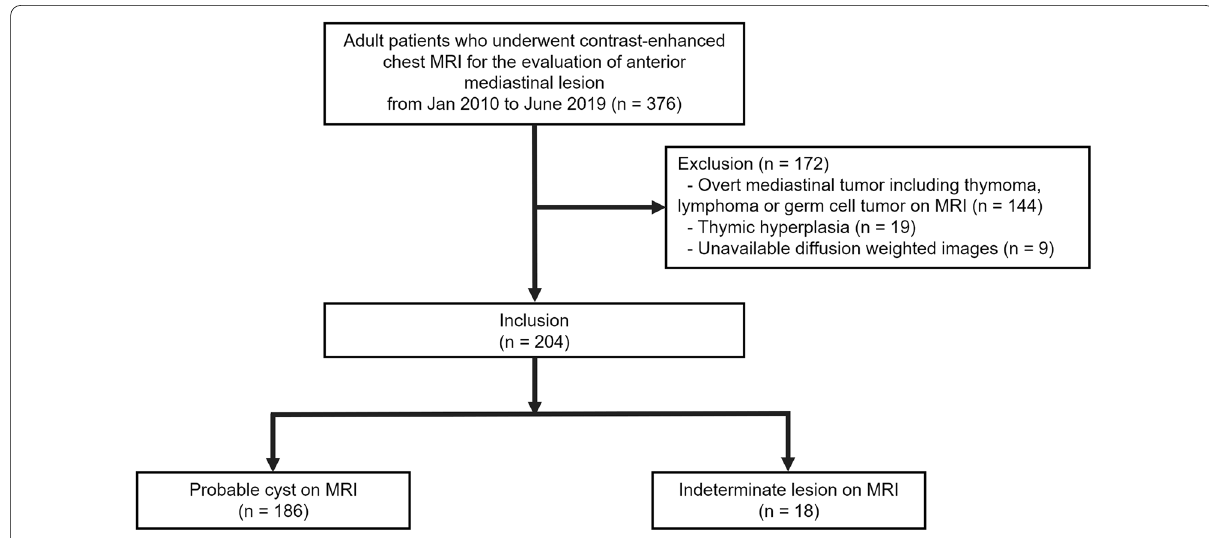
Fig. 1 Flowchart of study